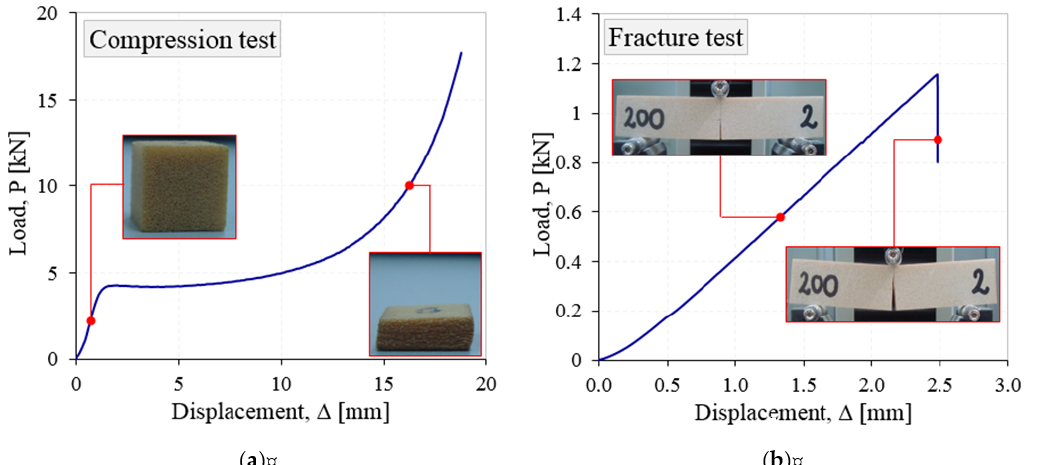
Figure 2. Load–displacement curves after compression ( a ) and three-point bending ( b )